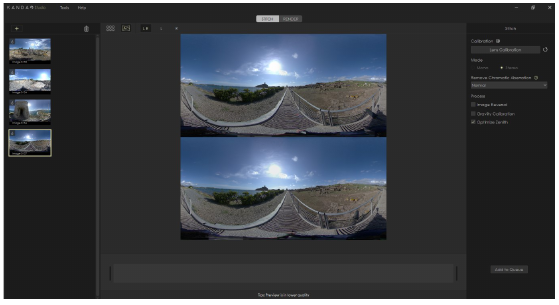
Figure 9. Processing of the panoramic view using the Kandao Studio software.